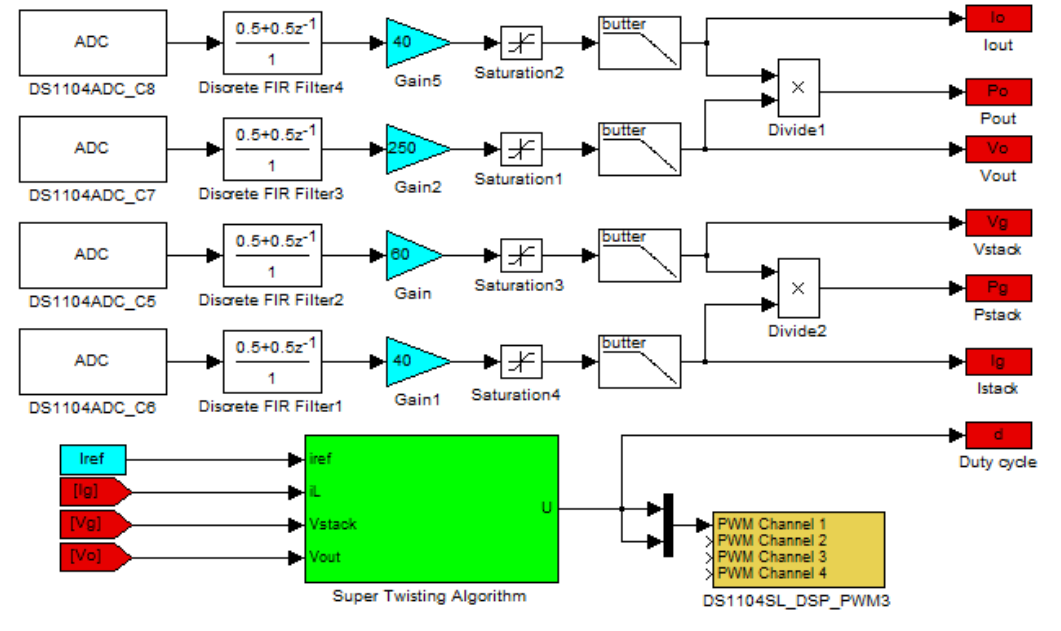
Figure 8. Control design in MATLAB/Simulink